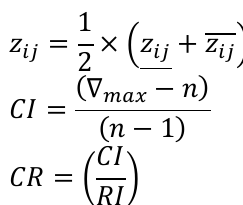
Table 3 Linguistic terms and their Grey Weights Linguistic Weights Grey Weights Absolute Significant (AS) Moderately Significant (MS) 2 nd stride: First, grey values are translated into crisp values with the aid of Eq. (3). Then,